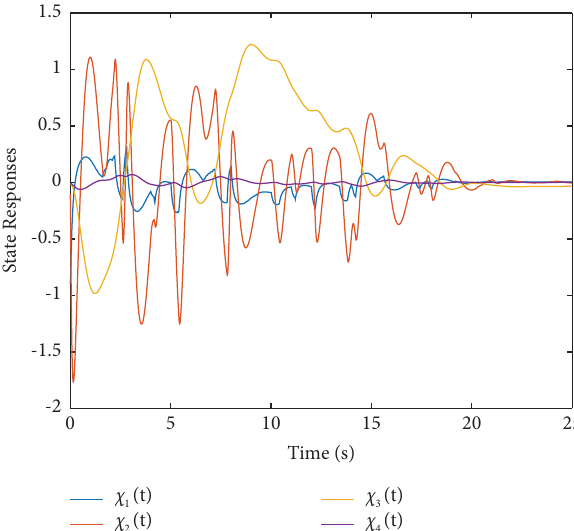
Figure 8: Te state trajectories χ ( t ) for